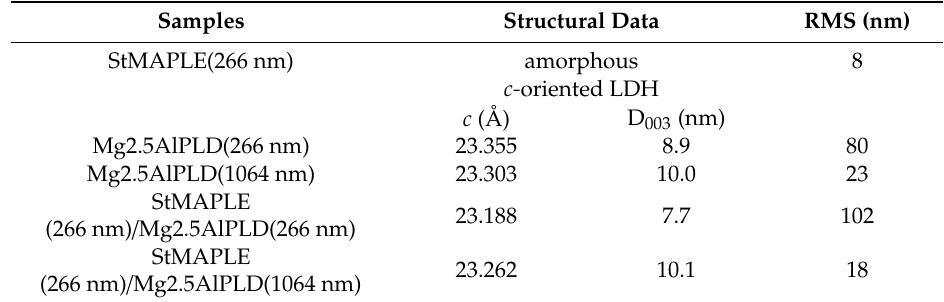
Figure 3. XRD patterns of the as-deposited films. Table 2. Structural data derived from XRD analysis and the roughness defined through the root mean square (RMS) deviations from AFM measurements.